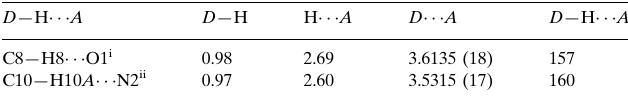
Hydrogen-bond geometry (A˚ , (cid:1)